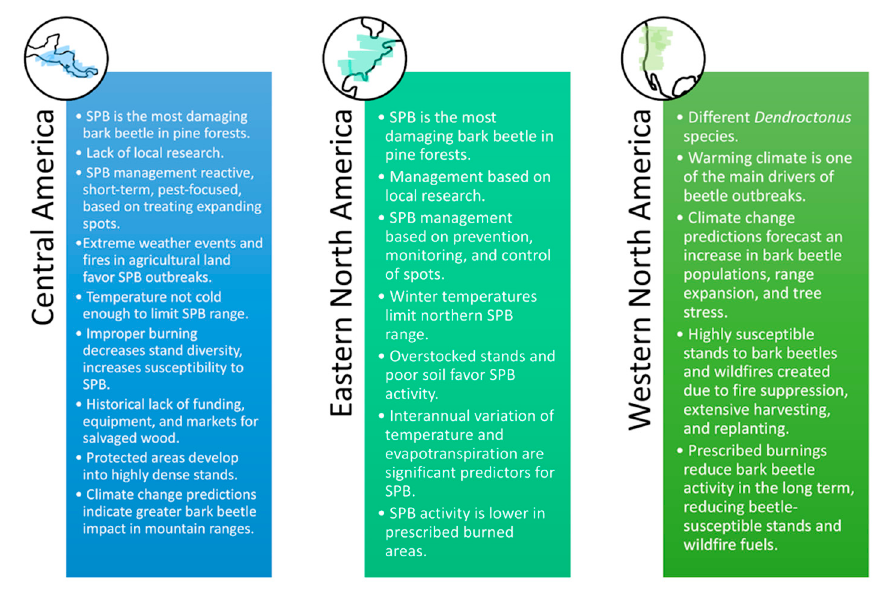
Figure 1. Regional differences in bark beetle outbreak drivers and management